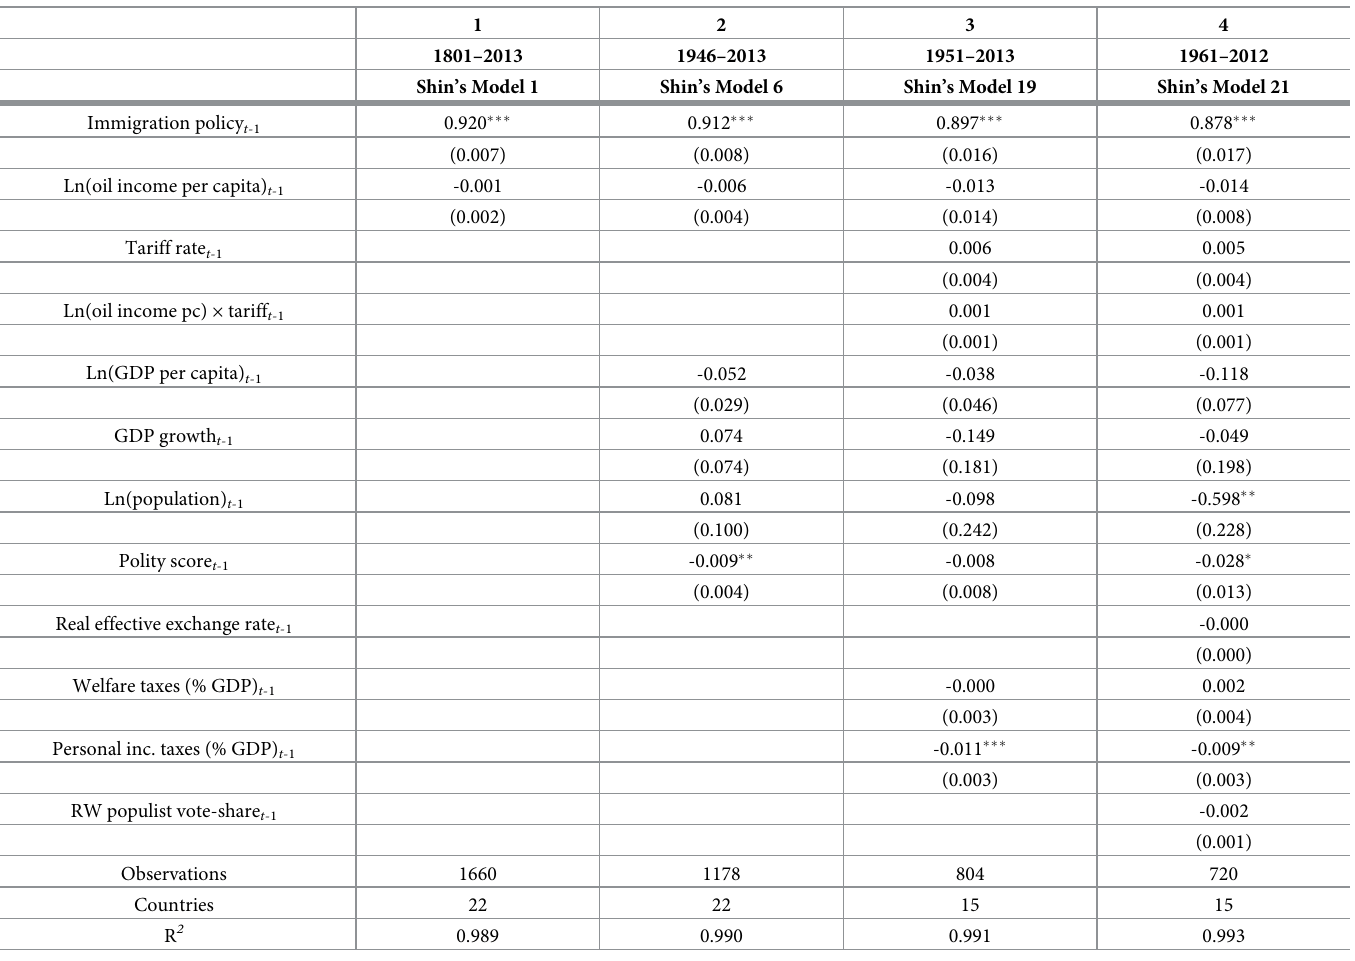
Table 3. Oil wealth and immigration policy: Two countries